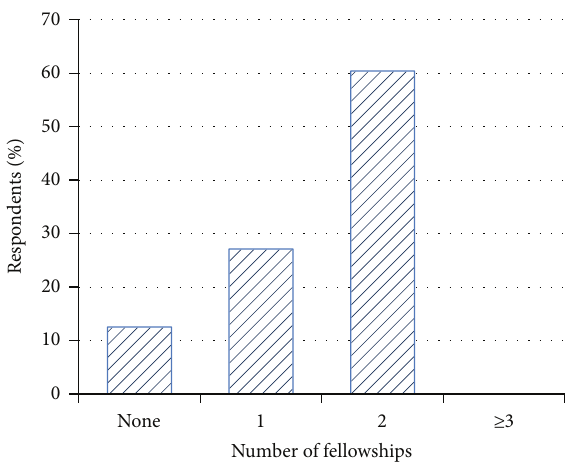
Figure 1: Number of fellowships being pursued by PGY-4 and PGY- 5 respondents. Graphic illustration of survey responses demon- strating 11% ( 𝑛 = 6 ) residents not pursuing any fellowships, 27% ( 𝑛 = 13 ) pursuing a single fellowship, and 60% ( 𝑛 = 29 ) pursuing two fellowships. No respondents were pursuing more than two fellowships.